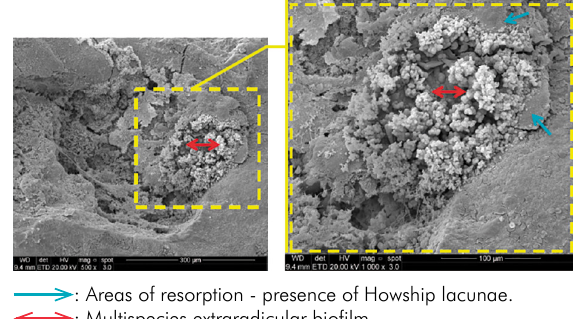
Figure 2. SEM at 500x and SEM at 1000x indicating both multispecies microbial biofilm and areas of resorption with the presence of Howship lacunae.